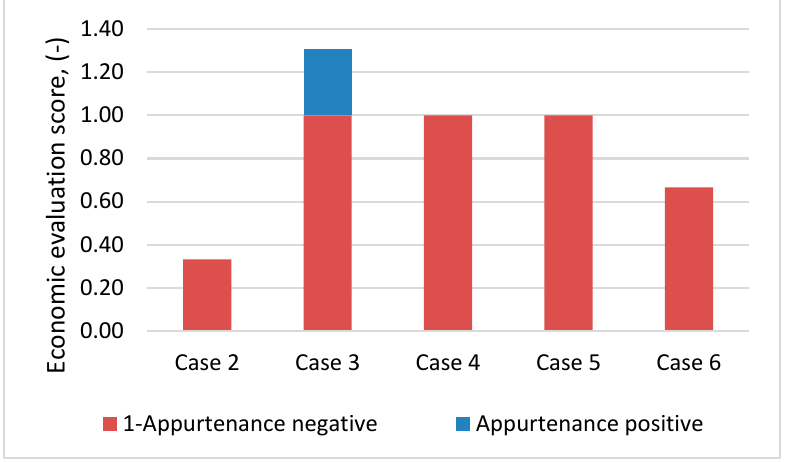
Figure 10. The overall evaluation of the cases studied according to the economic criteria.